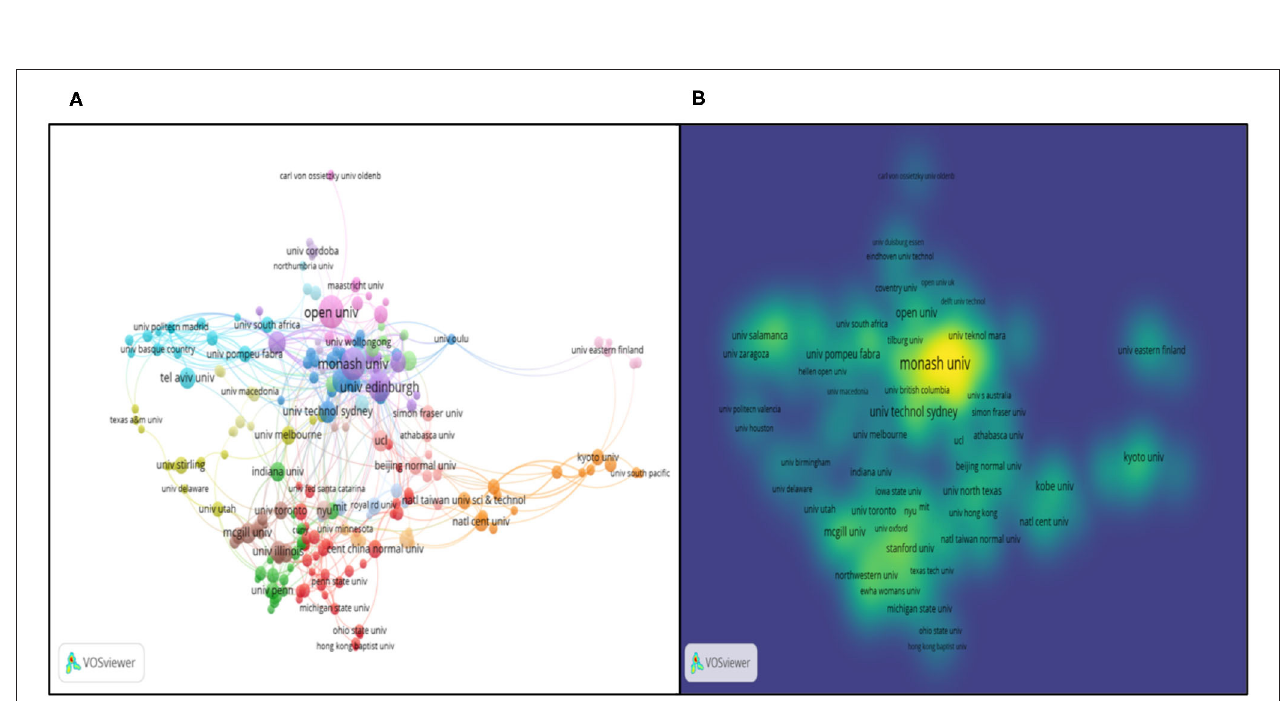
FIGURE 13 | Co-authorship analysis of research organizations. (A) Network visualization map based on document weights; (B) Density visualization based on total link weights.